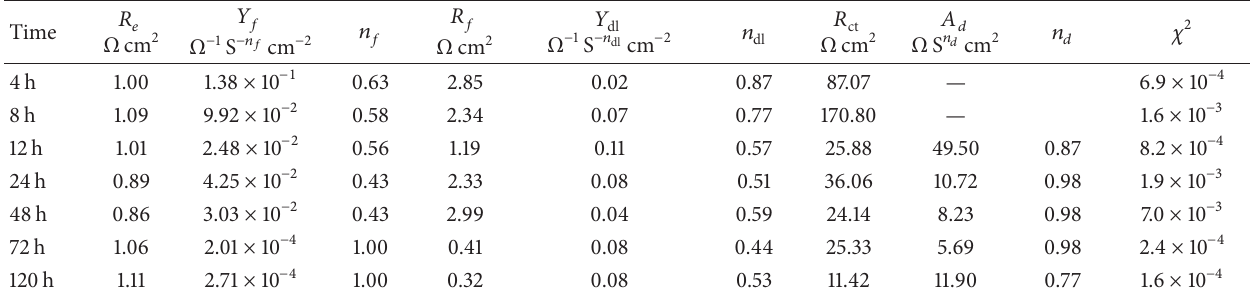
Table 4: Results of the CNLS fit to EIS data of SS310.